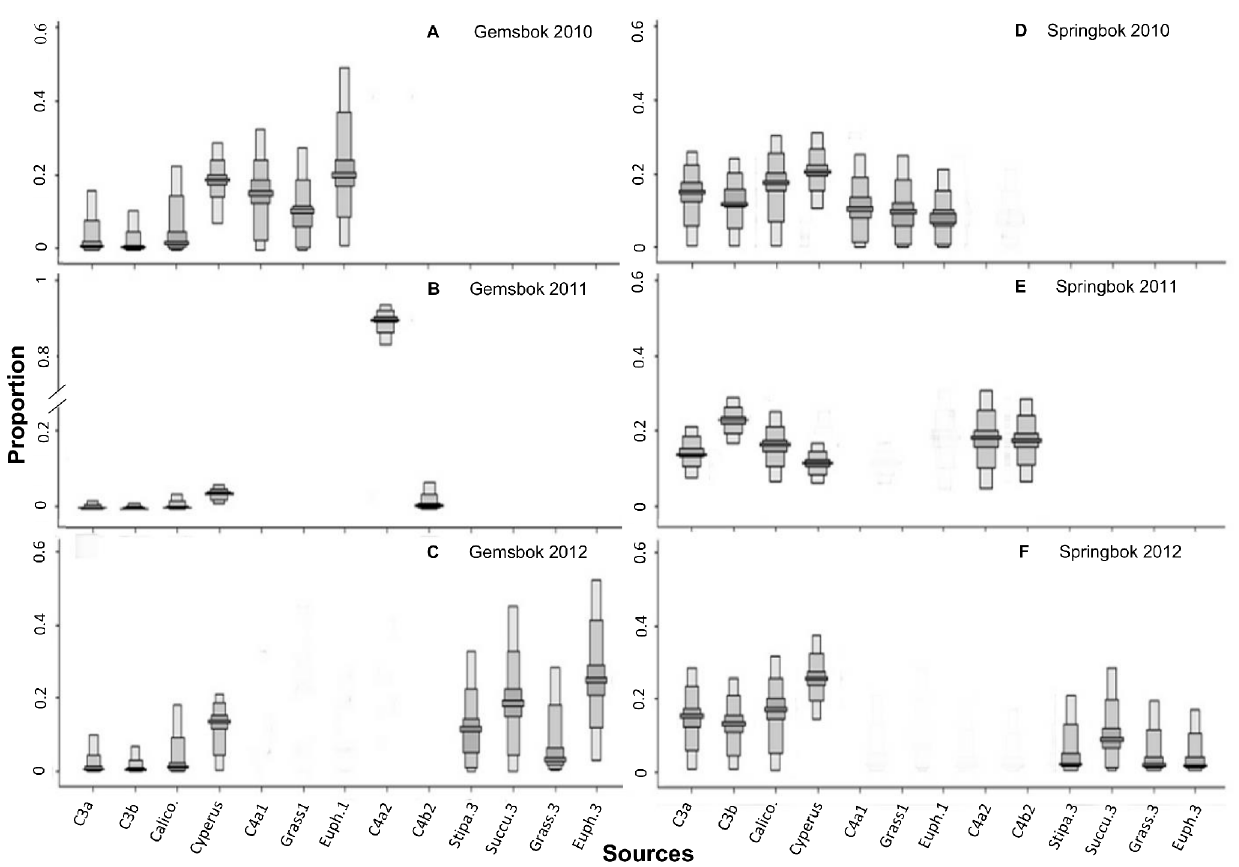
Figure 3. Relative contribution of the potential food sources to the diets of gemsbok (A,B,C) and springbok (D, E, F), as determined by our SIAR isotope mixing model relative to the mean composition of the three metabolically active tissues analysed (blood, liver, muscle) for 2010 (A and D); 2011 (B and E) and 2012 (C and F). The boxplots show the relative proportions of each food source with 95% (dark grey), 75%, 25% and 5% (lightest grey) credibility